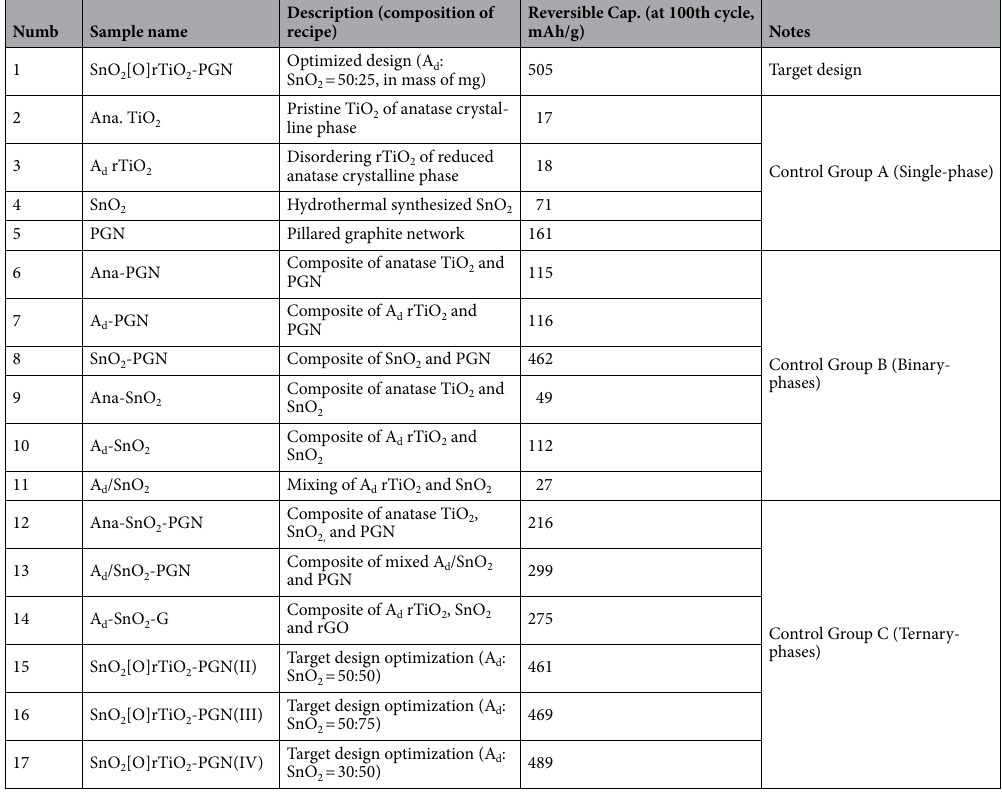
Table 1. The list of investigated samples in this study and the corresponding description of each